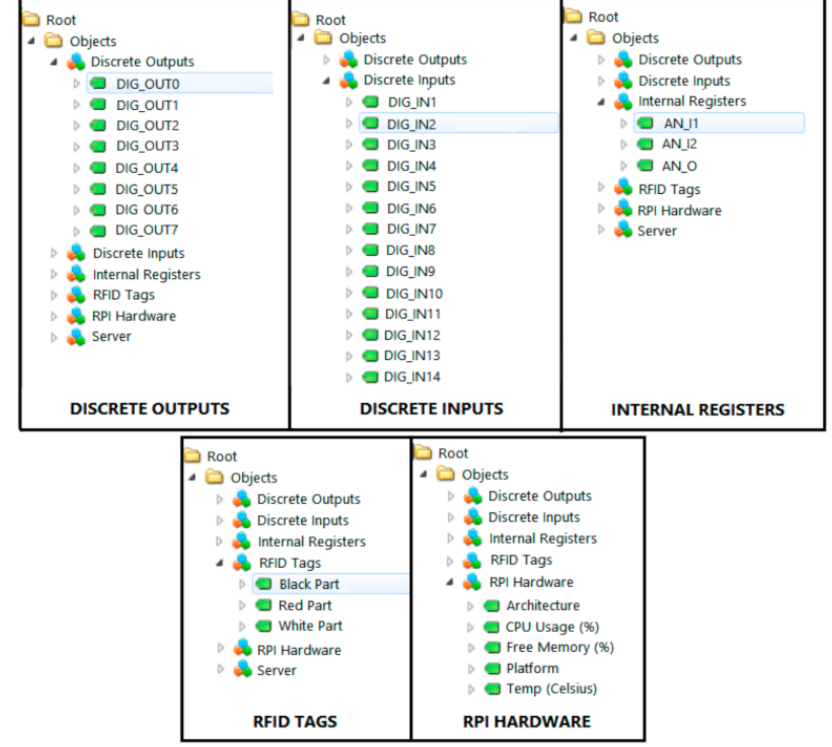
Figure 4. Control device address space of the open platform communication unified architecture (OPC UA)